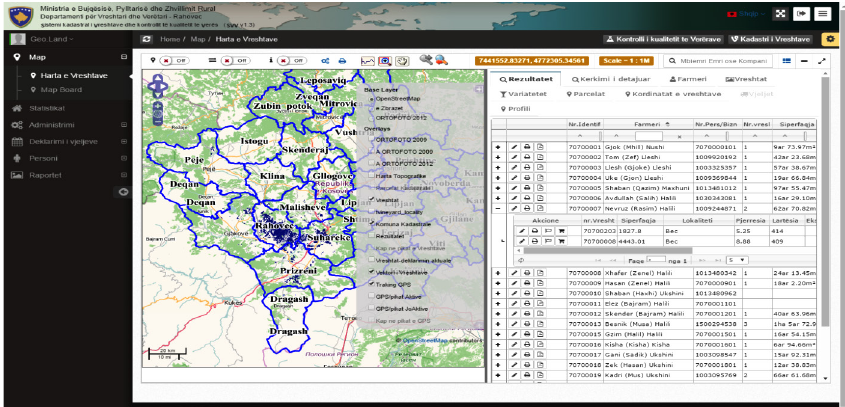
Figure 16. General Presentation (GUI) of Vineyard